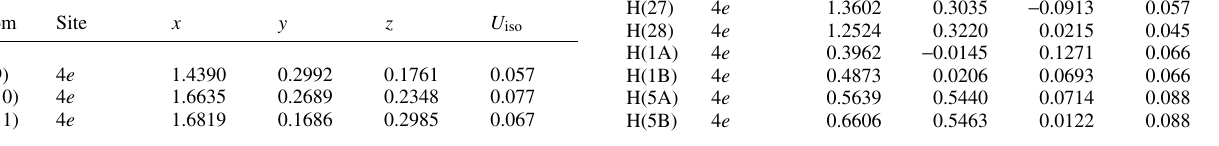
Table 2. Atomic coordinates and displacement parameters (in Å 2 )